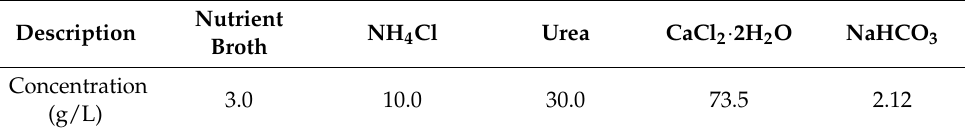
Table 2. Calcium source solution.